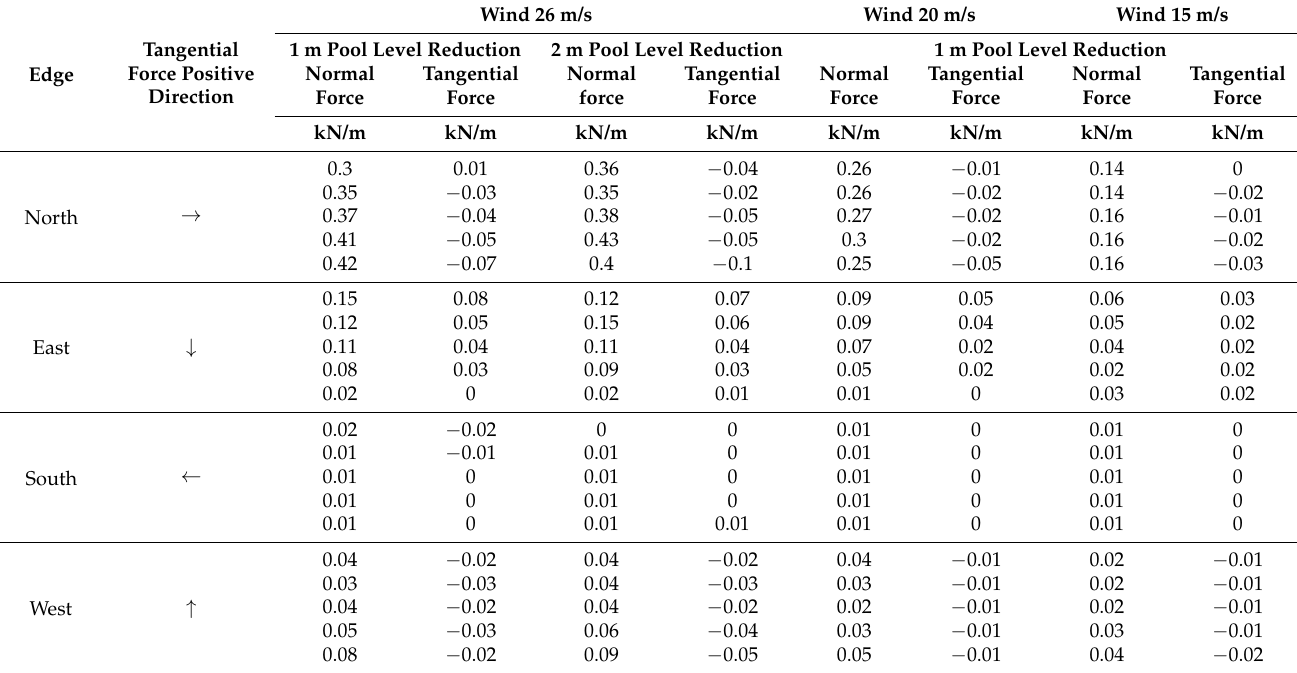
Table 3. Forces resulting from static ice pressure on the PV installation in the conditions of the northern wind with variable